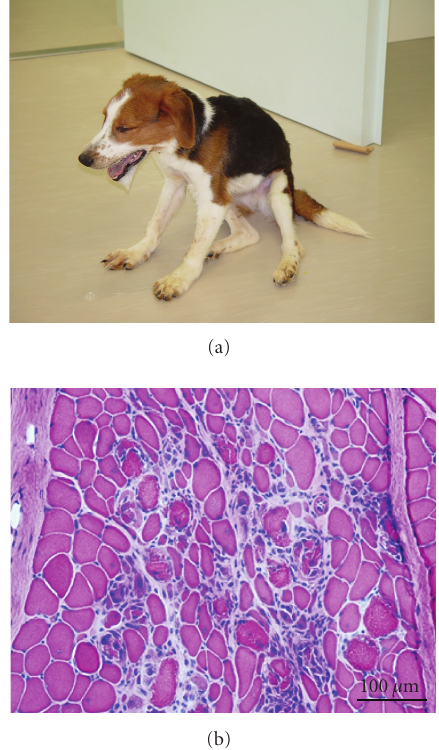
Figure 2: (a) A male canine with X-linked muscular dystrophy (CXMD J ) at 6 months of age. The atrophy of muscles throughout the body (including temporal muscle) is observed. Kyphosis, abnormal sitting posture, and contracture of hindlimb joints are seen. (b) The pathology (H and E) of tibialis cranialis muscle indicates muscle necrosis with infiltration of inflammatory cells, centrally nucleated fibers, and increased interstitial connective